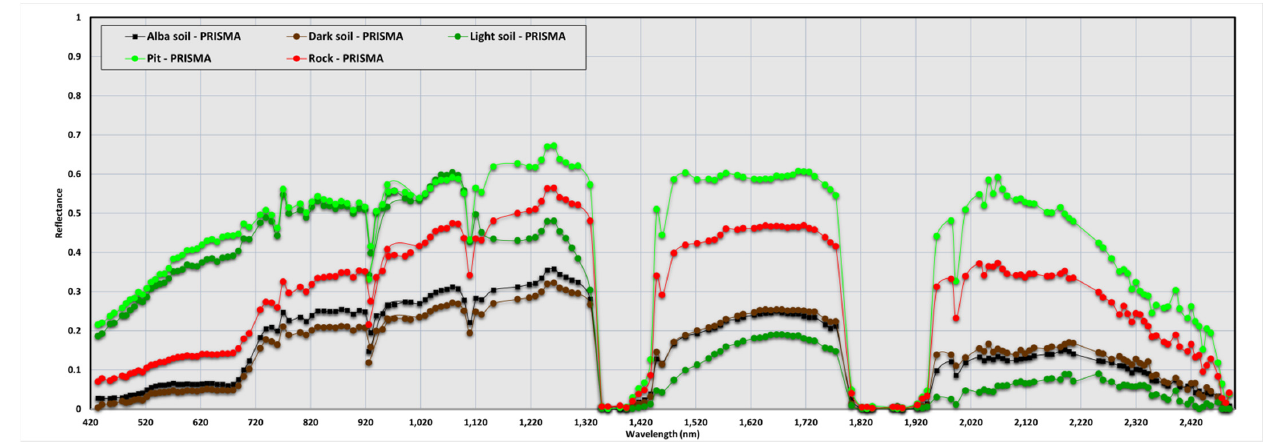
Figure 18. Comparison between the PRISMA spectral signatures in the Alba Fucens area.